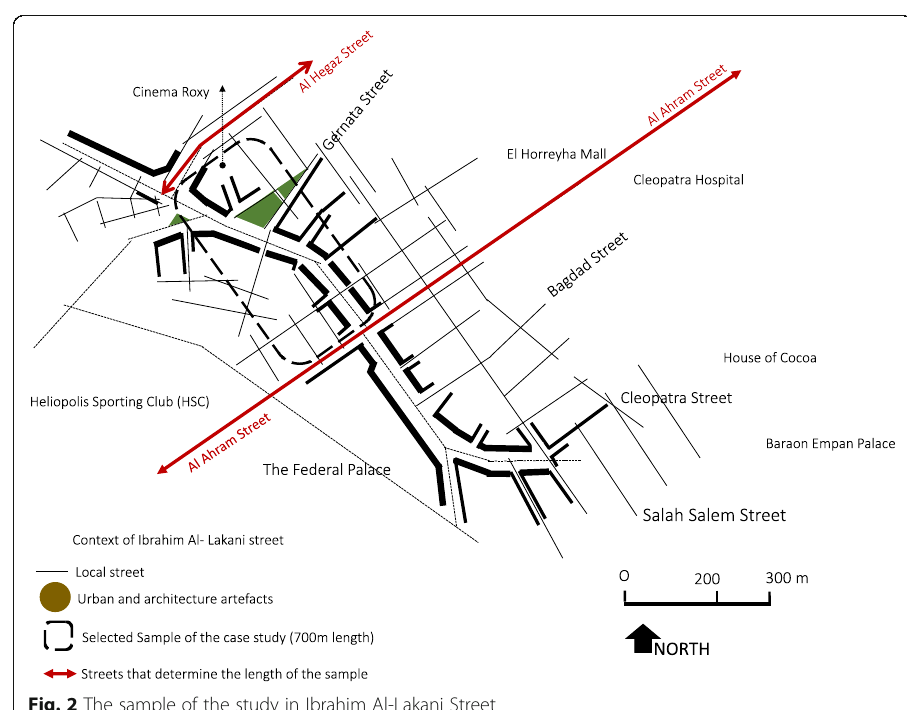
Fig. 2 The sample of the study in Ibrahim Al-Lakani